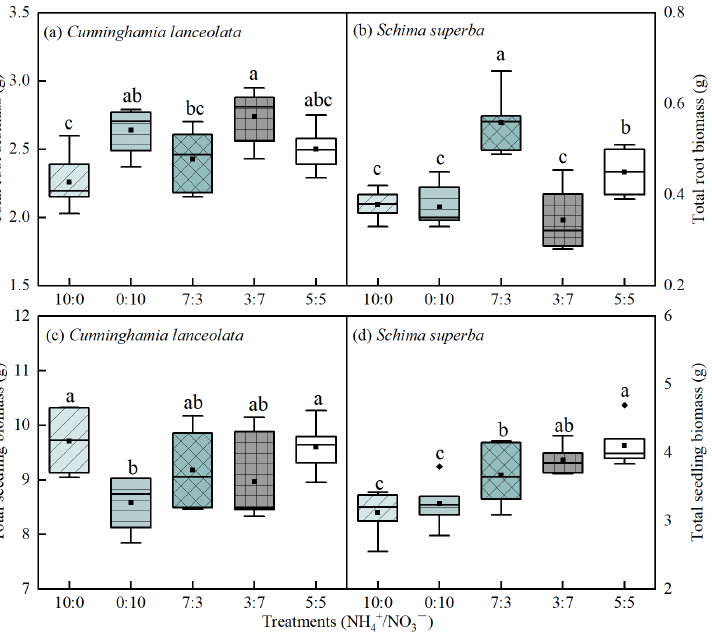
Figure 2. Effects of different NH 4+ -N and NO 3 − -N ratios on the TRB ( a , b ) and TSB ( c , d ) of the two tree species. Different lowercase letters indicate that TRB and TB were significantly different under different N forms ( p < 0.05).